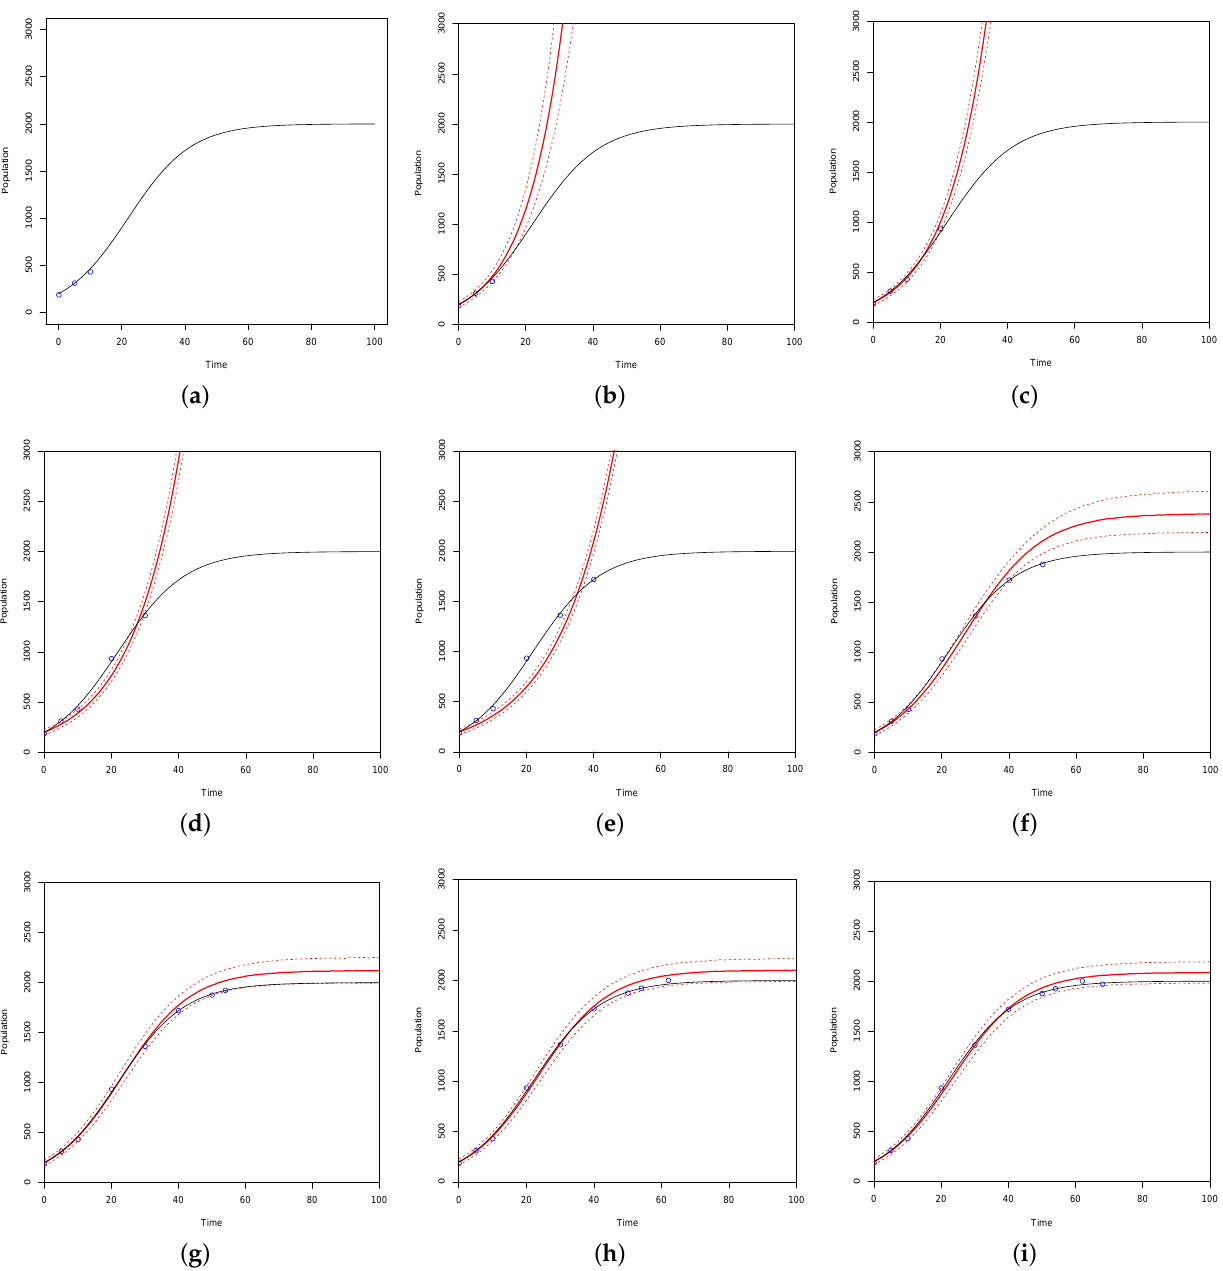
Figure 7. 10,000 MCMC samples are used to simulate the normal 10% growth curve across a 100 day period with a carrying capacity of 2000. The ground truth model is plotted as a black curve. I-optimality criterion guides the sequential optimality process. The optimal design points are plotted in blue and are fit by a solid red curve. The red dotted lines represent the 2.5% and 97.5% quantiles of the predicted values. Panel ( a ) plots the base design of three points, panel ( b ) plots the fit of the base design, and panels ( c – i ) plot the fourth through tenth optimal points in the design as they are fit. The simulations of normal growth show varying results in Figure 8 across the opti- mality criteria. The I and A Φ optimal designs successfully capture the dynamics of the population with ten points. Whereas, the D Φ optimal design did not capture the dynamic of the carrying capacity. This indicates the need for a larger design point budget or